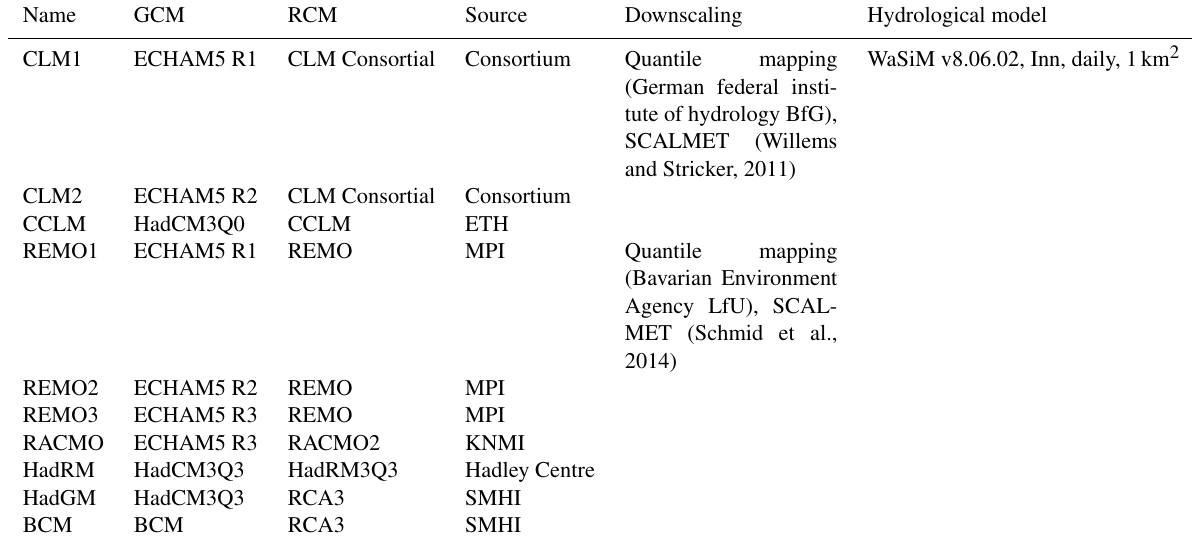
Table 1. Regional climate models (RCMs) used in this study, driving global climate models (GCMs), source of the RCMs, downscaling and hydrological